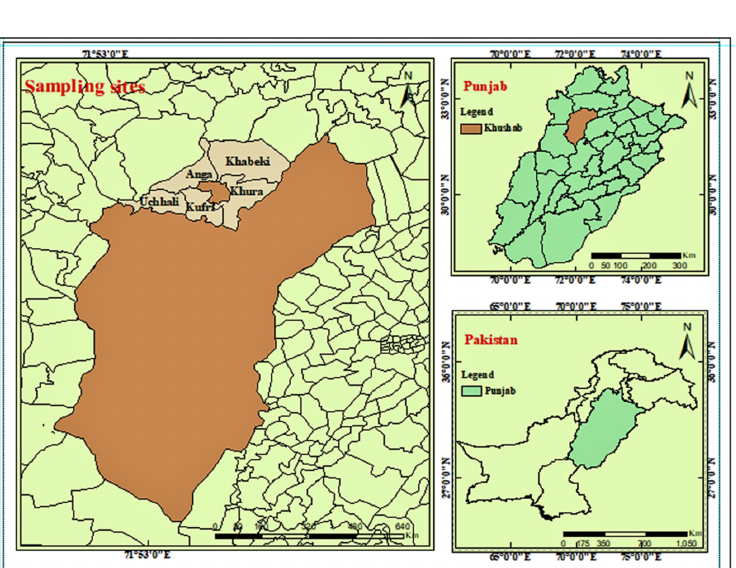
Figure 1. Locations selected for the collection of flora of Soone Valley and the surrounding salt range of Pakistan. Table 1. Description of plant samples collected from the selected sites of Soone Valley (Khushab) and the surrounding salt range of Pakistan.